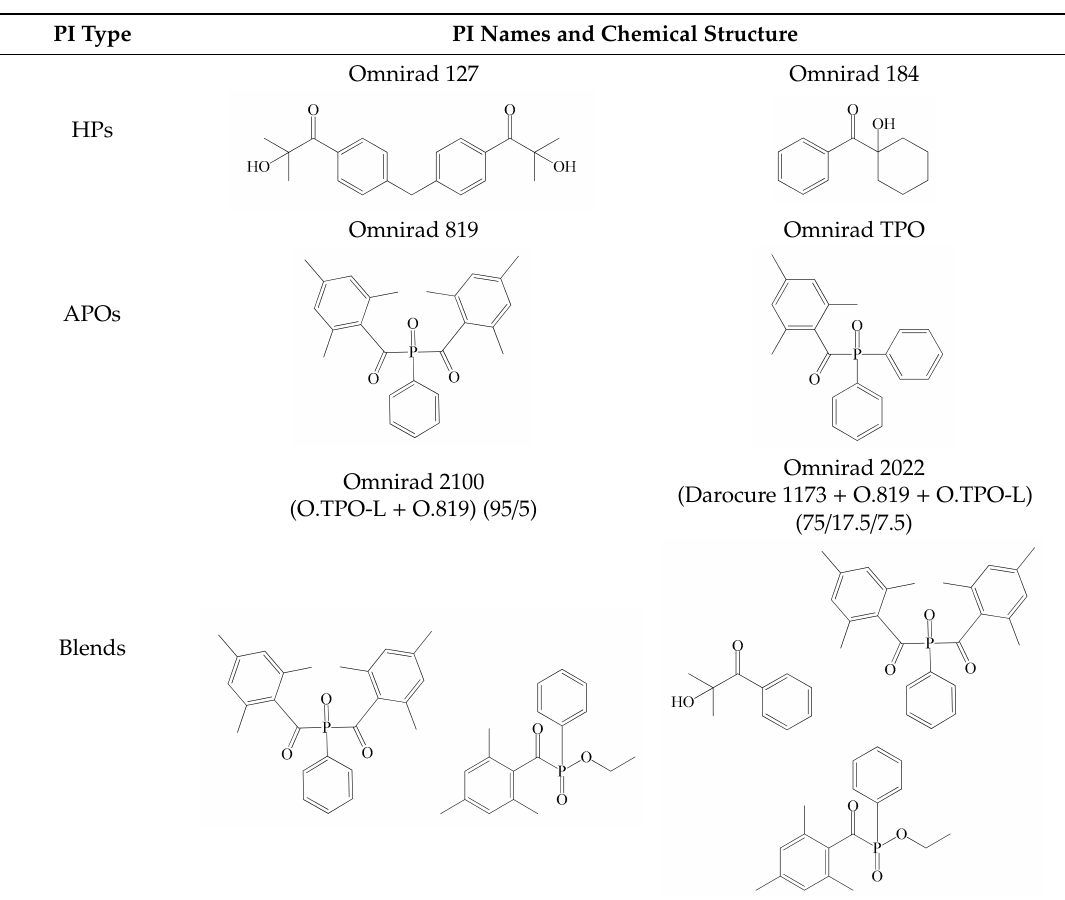
Table 1. Structures of tested photoinitiators